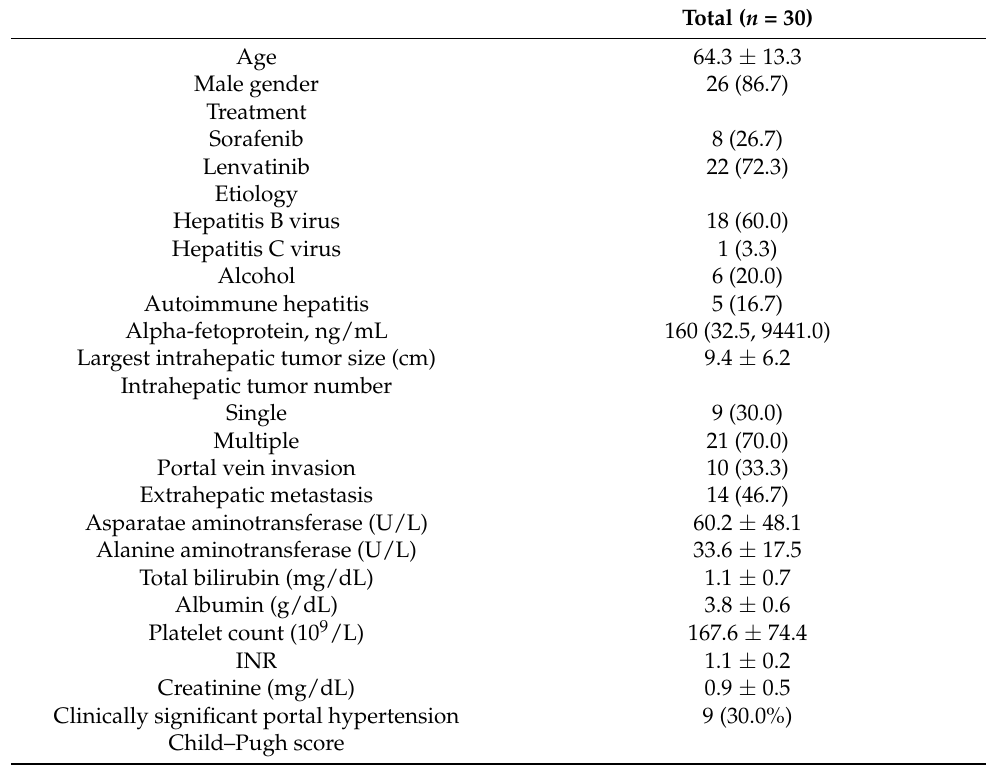
Table 1. Baseline